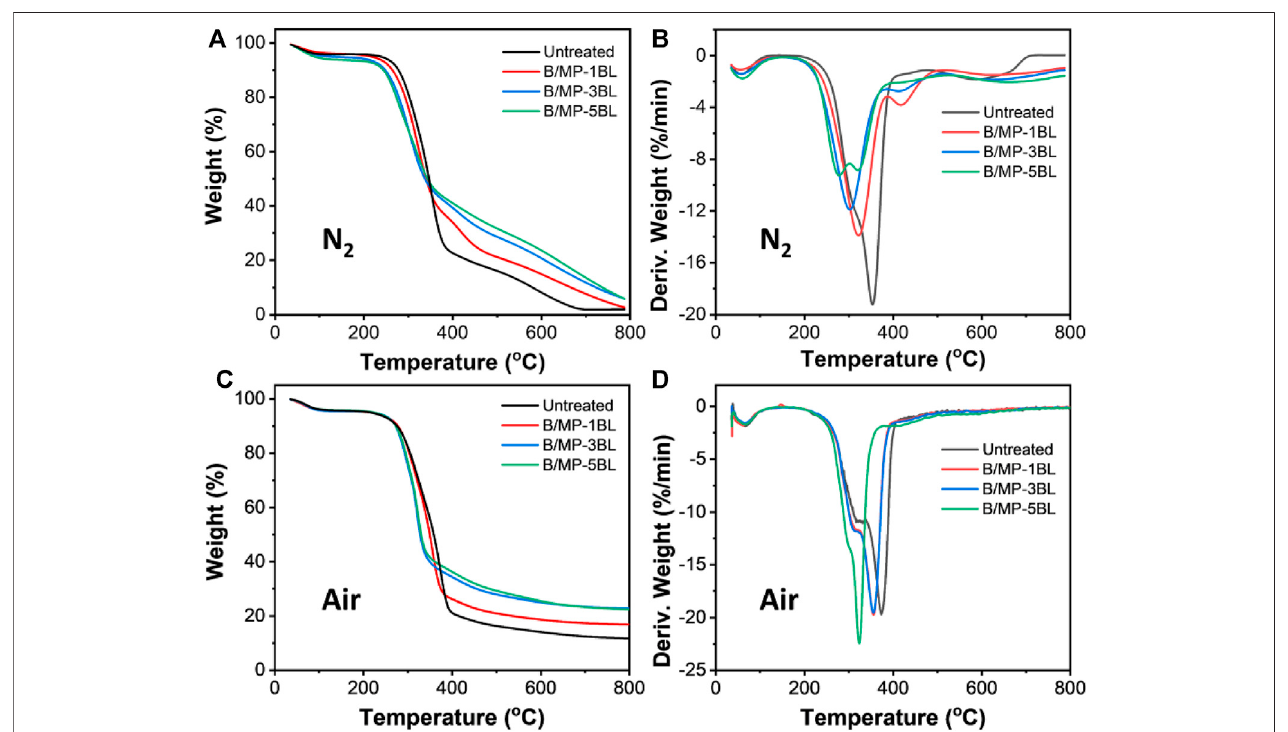
FIGURE 4 | TG and DTG pro fi les of untreated and treated bamboo slices under nitrogen (A, B) and air atmospheres (C, D) .